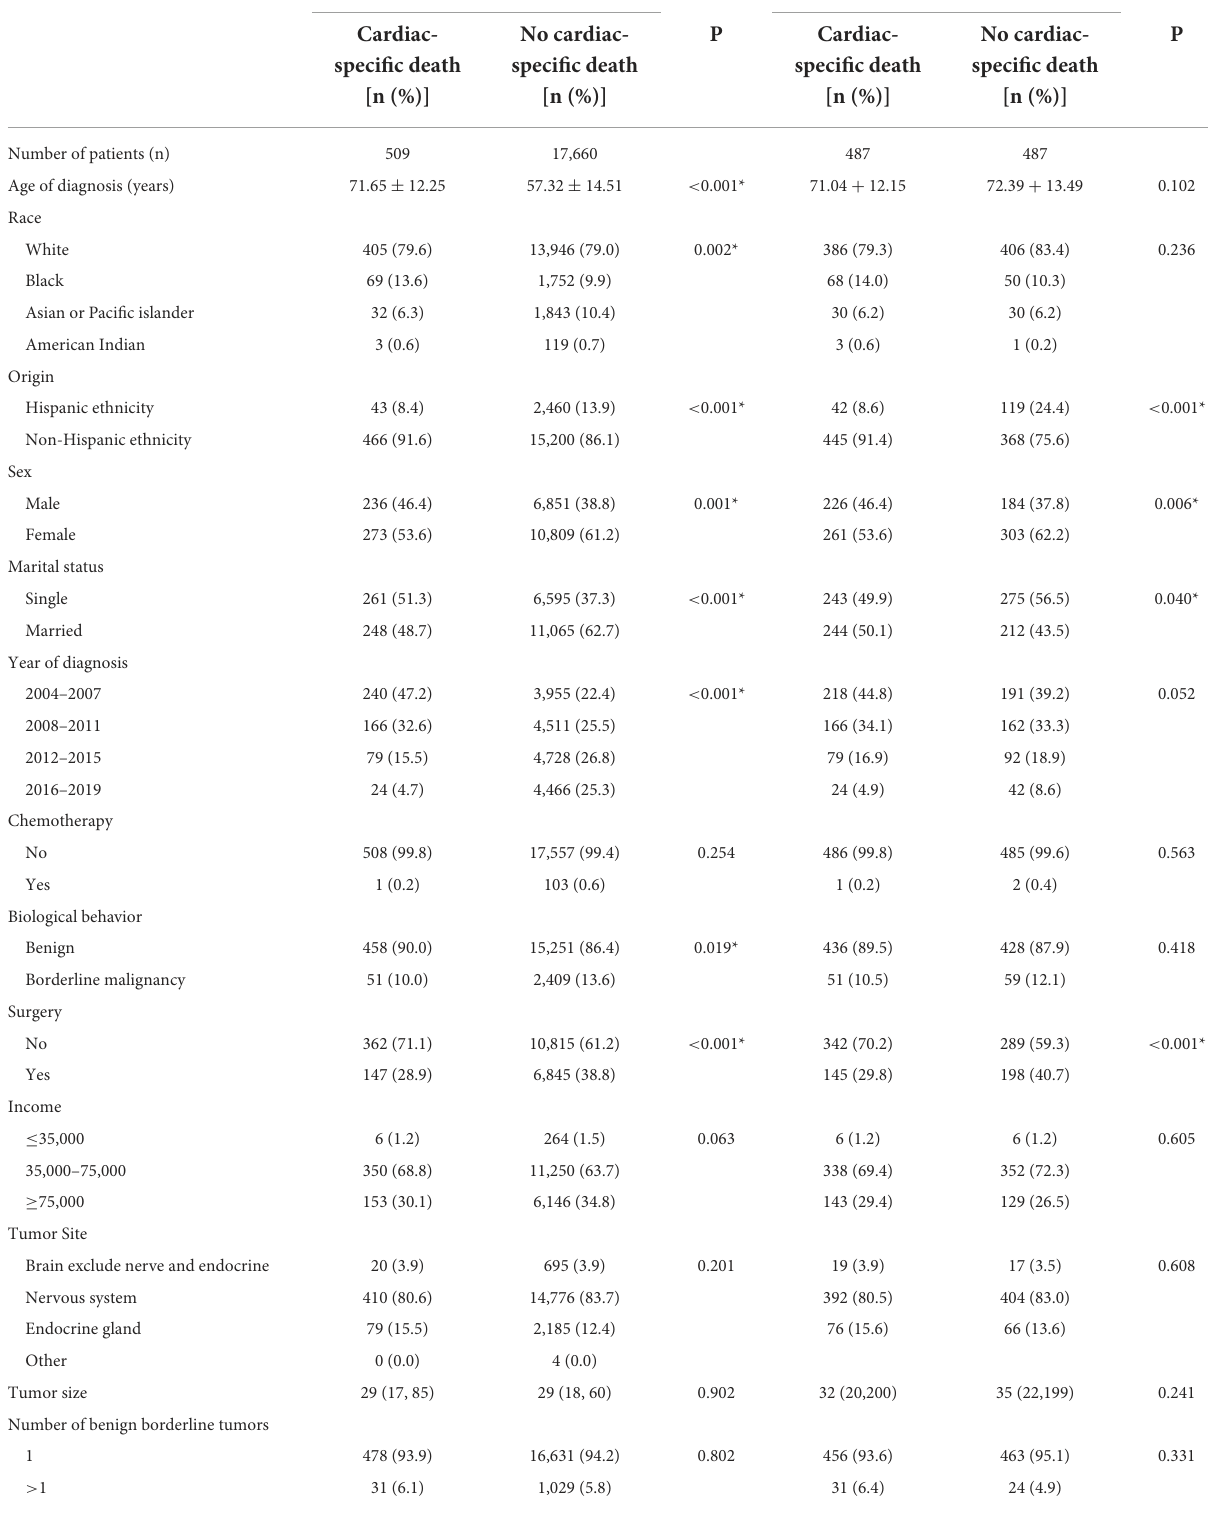
TABLE 2 Characteristics of patients included in patients with non-malignant tumors of CNS receiving